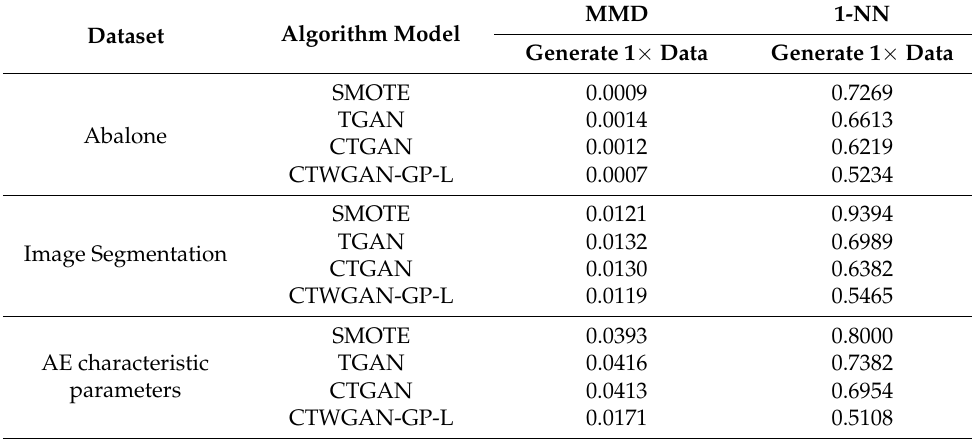
Table 6. Quality assessment of data generated by each